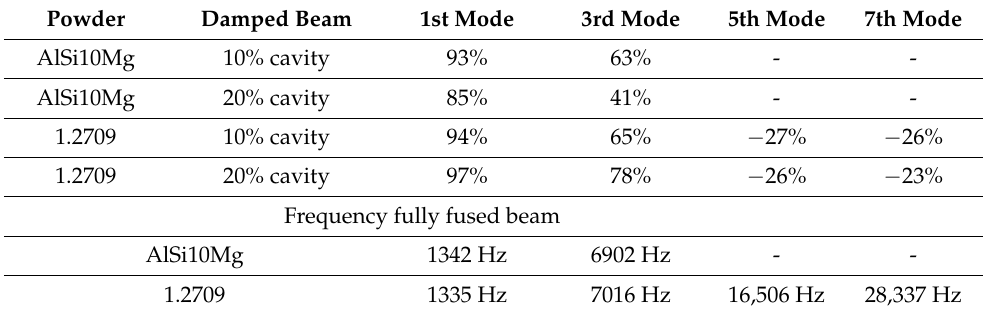
Table 4. Amplitude reduction of the FRF and natural frequencies related to Figure